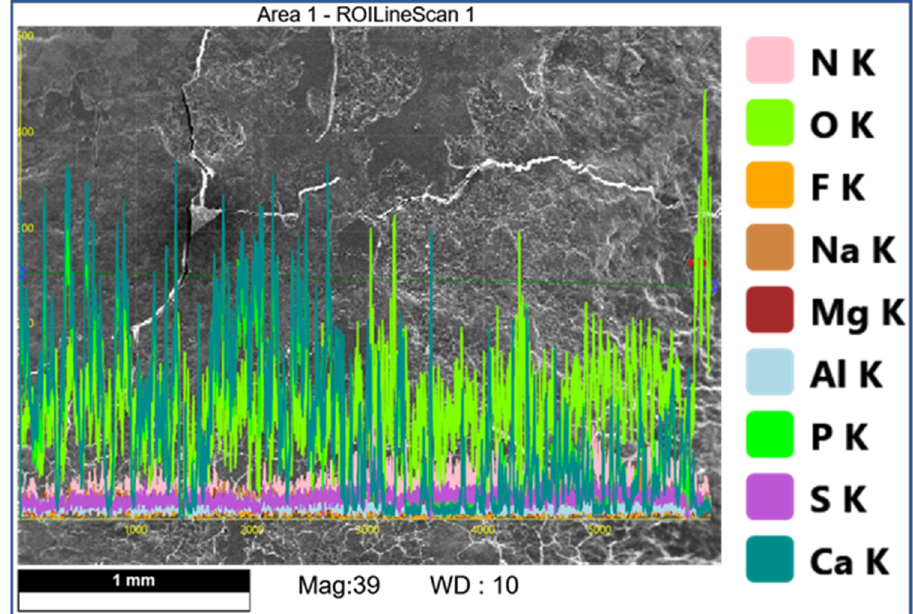
Figure 9. SEM of SRP-only specimen with overlay of color-coded EDS line scan showing peaks (from baseline) for F, Al, S, N, Ca, P, and O. Mg and N are present but in low concentrations and are barely discernable. The scan traversed a line of ≈ 3 mm in length which included the smear layer resulting from SRP. Original mag. 39×; Bar = 1 mm. Working distance of 10 mm.